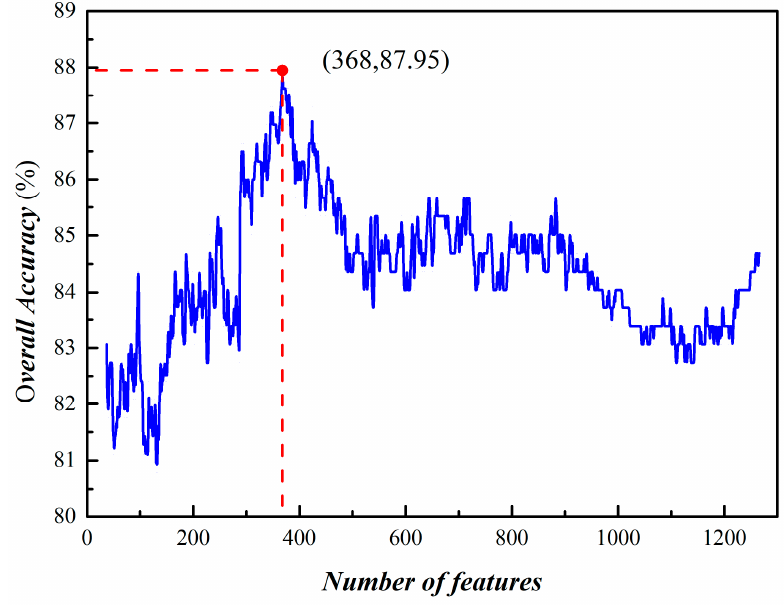
Figure 4. A plot showing the IFS curve by using mRMR. Molecules 2018 , 23 , x FOR PEER REVIEW